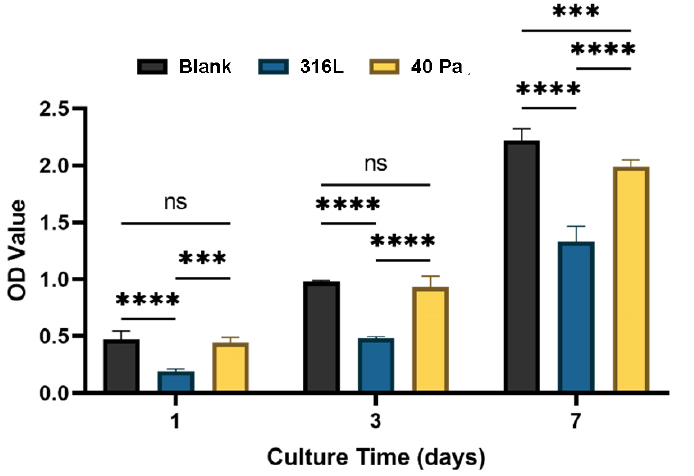
Figure 11. Absorbance maps of cells in the blank control group, matrix group, and alloying layer group after 1, 3, and 7 days of proliferation. (*** p < 0.0005, **** p < 0.0001).